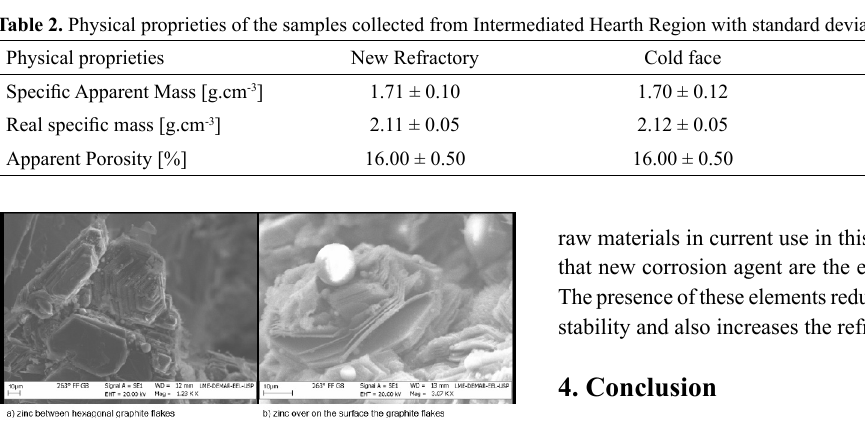
Figure 5. Microstructure’s image by SEM/EDS indicating zinc deposition: a) between hexagonal graphite flakes and b) over on the surface the graphite flakes.